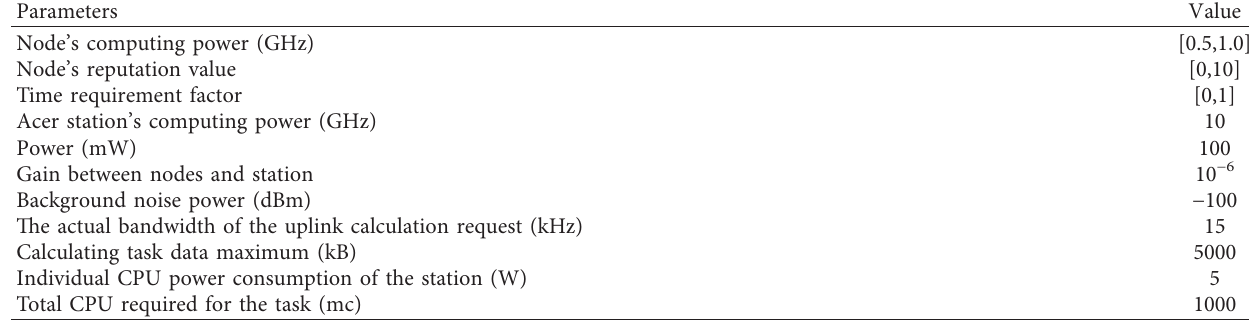
Table 4: Specific physical model parameter settings.